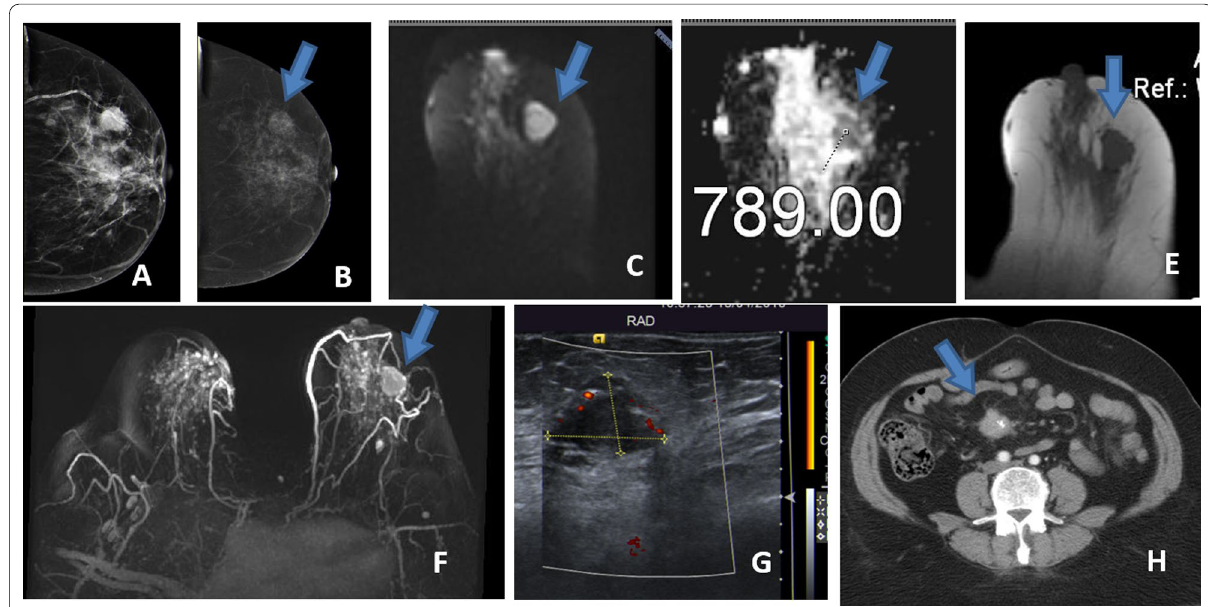
Fig. 4 A 72-year-old female with an incidentally discovered single circumscribed left breast mass with homogenous enhancement as seen on mammogram CC view ( A ) and recombined CESM ( B ). C and D DWI b value value 0.789 10 − 3 mm 2 /s E Axial MRI Left breast shows hypointense mass with smooth margin F DCE-MRI 3D MIP shows the left breast mass with = × feeding vessels (arrow) G US shows the mass with circumscribed margin, posterior enhancement and advancing anterior edge. Note peripheral vascularity by color Doppler. Core biopsy revealed metastatic NEC, triple negative. H Axial CT scan shows the primary mesenteric carcinoid tumor with